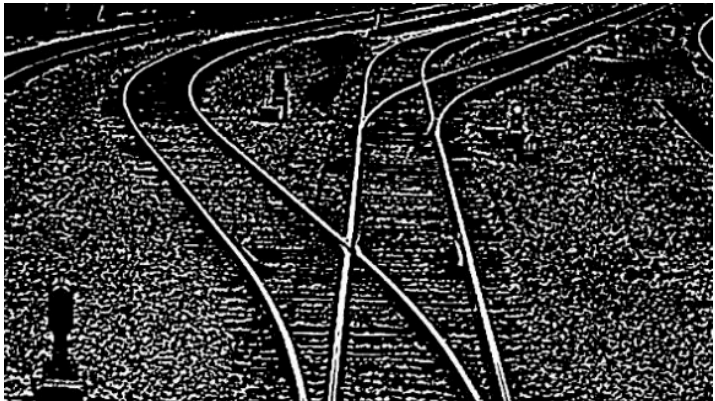
Figure 5. The result after adaptive threshold segmentation.